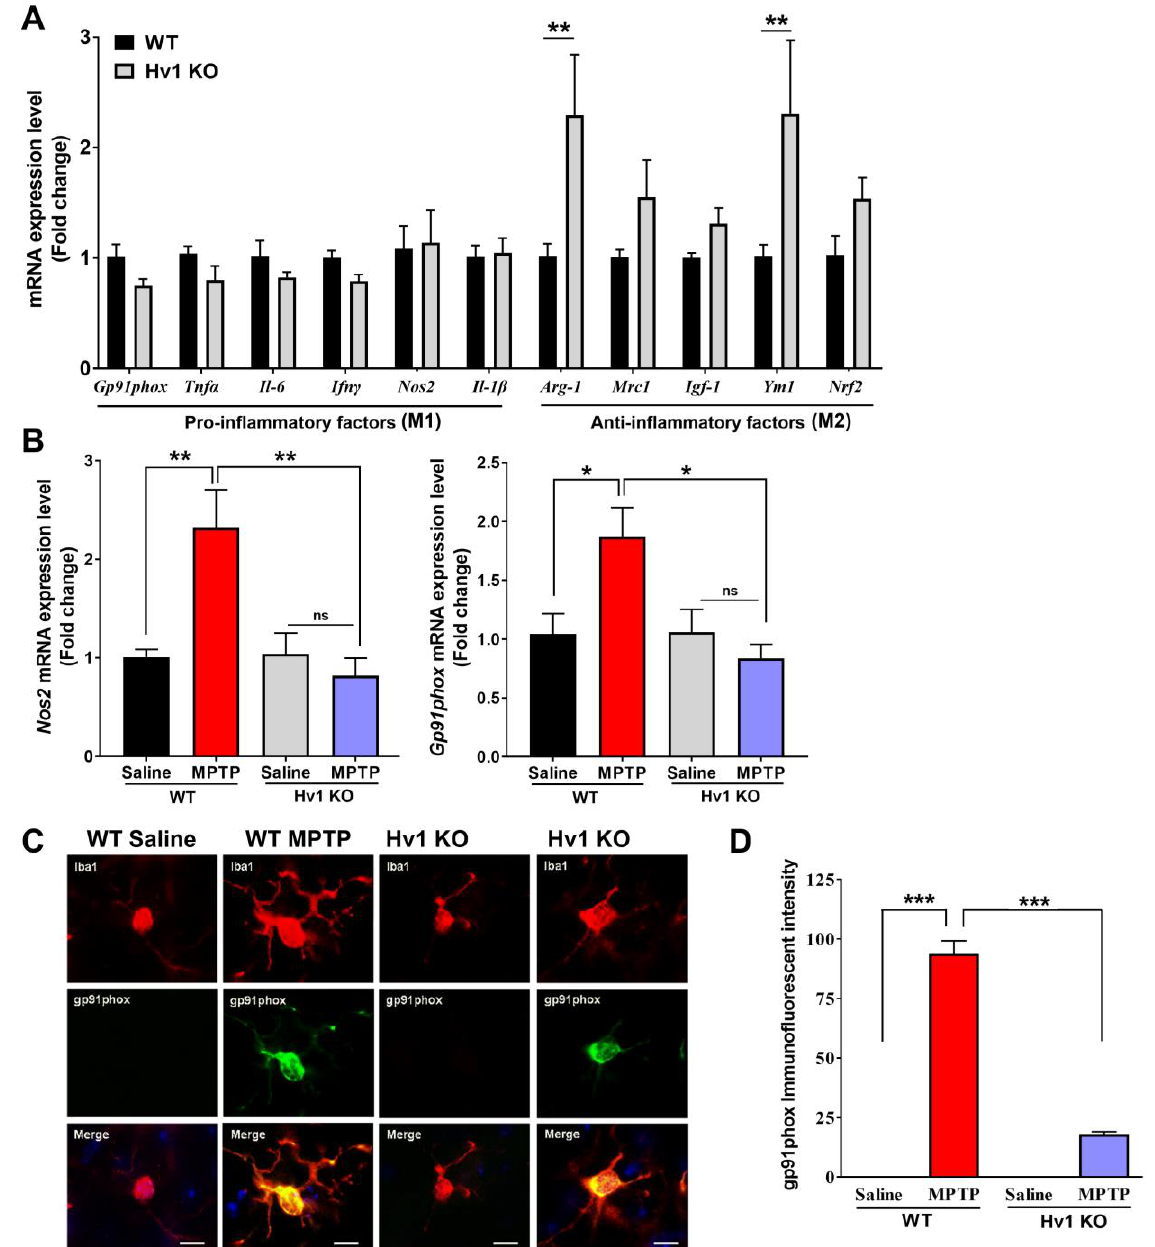
Figure 3. Basal inflammatory status and MPTP-induced ROS and NO are reduced in Hv1 KO mice. ( A ) Quantitative PCR results for basal levels of pro-inflammatory factors ( Gp91phox , Tnf α , Il-6 , Ifn γ , Nos2 , and Il-1 β ) and anti-inflammatory factors ( Arginase-1 , Mrc1 , Igf-1 , Ym1 , and Nrf2 ) in the striatum of Hv1 KO mice compared to WT mice. ** p < 0.01 using SEM by Student’s t -test. ( B ) Quantitative PCR results for the genes Nos2 (left) and Gp91phox (right) in the WT and Hv1 KO mouse striatum 2 days after MPTP treatment with MPTP treatment compared to saline for each genotype. ( C ) Representative immunofluorescent images of gp91phox (green) in IBA1-positive (red) cells, with DAPI nuclei stain (blue) in WT and Hv1 KO sections treated with saline or MPTP, scale bar 5 µ m. ( D ) Semi-quantification of Gp91phox protein fluorescent intensity levels. n = 4–5 mice per group for all experiments. Asterisks denote statistically significant differences—* p < 0.05, ** p < 0.01, *** p < 0.001, using two-way ANOVA followed by Tukey’s multiple comparisons. ‘ns’ indicates not statistically significant. Error bars denote the standard error of the